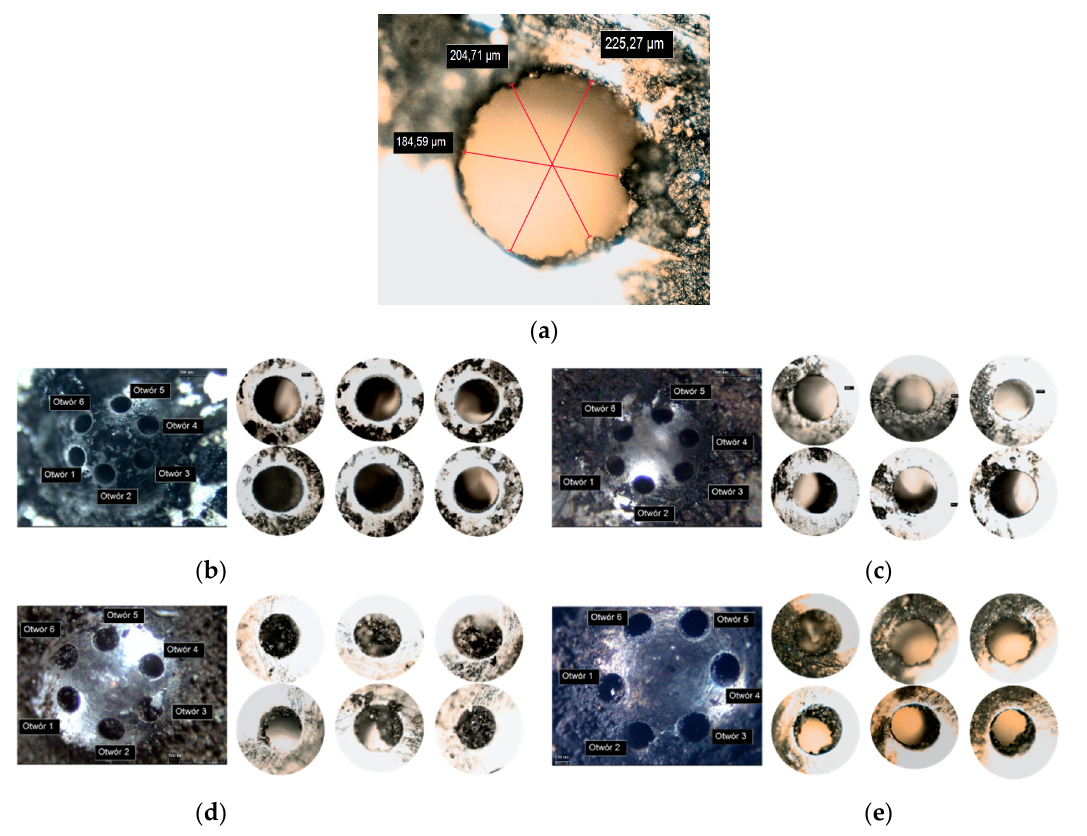
Figure 12. Images of the injector tips and holes after testing: ( a ) the hole diameter after the test as a determinant of the figure scale; ( b ) Keep ‐ Clean (base); ( c ) Keep ‐ Clean (base + 20B); ( d ) Keep ‐ Clean (base) + CleanUp (base + 20B); and ( e ) Keep ‐ Clean (base) + CleanUp (base + 20B + DCA).